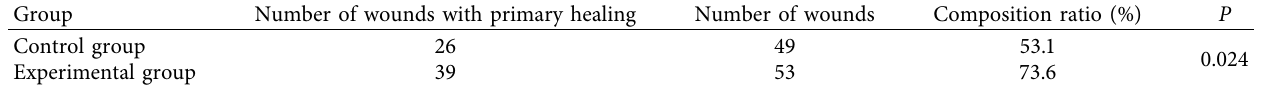
Table 2: Comparison of primary healing rate between the two groups.